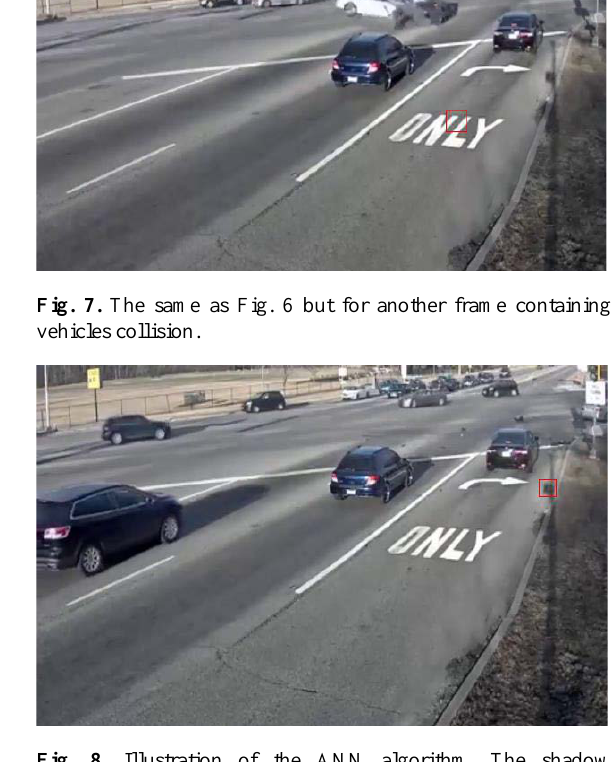
Fig. 8. Illustration of the ANN algorithm. The shadow is recognized instead of vehicles.